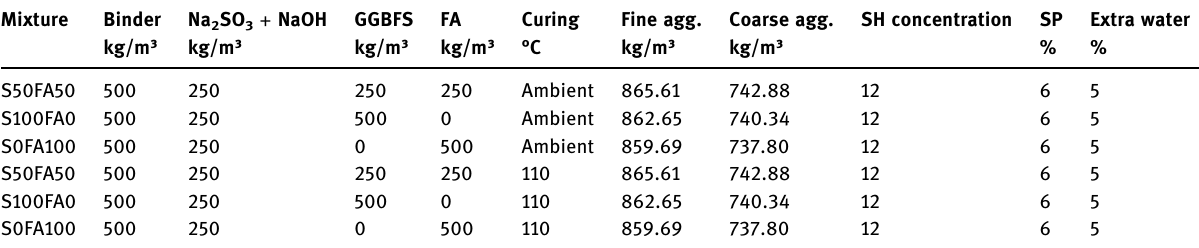
Table 4: The SCGC mixture proportions Mixture